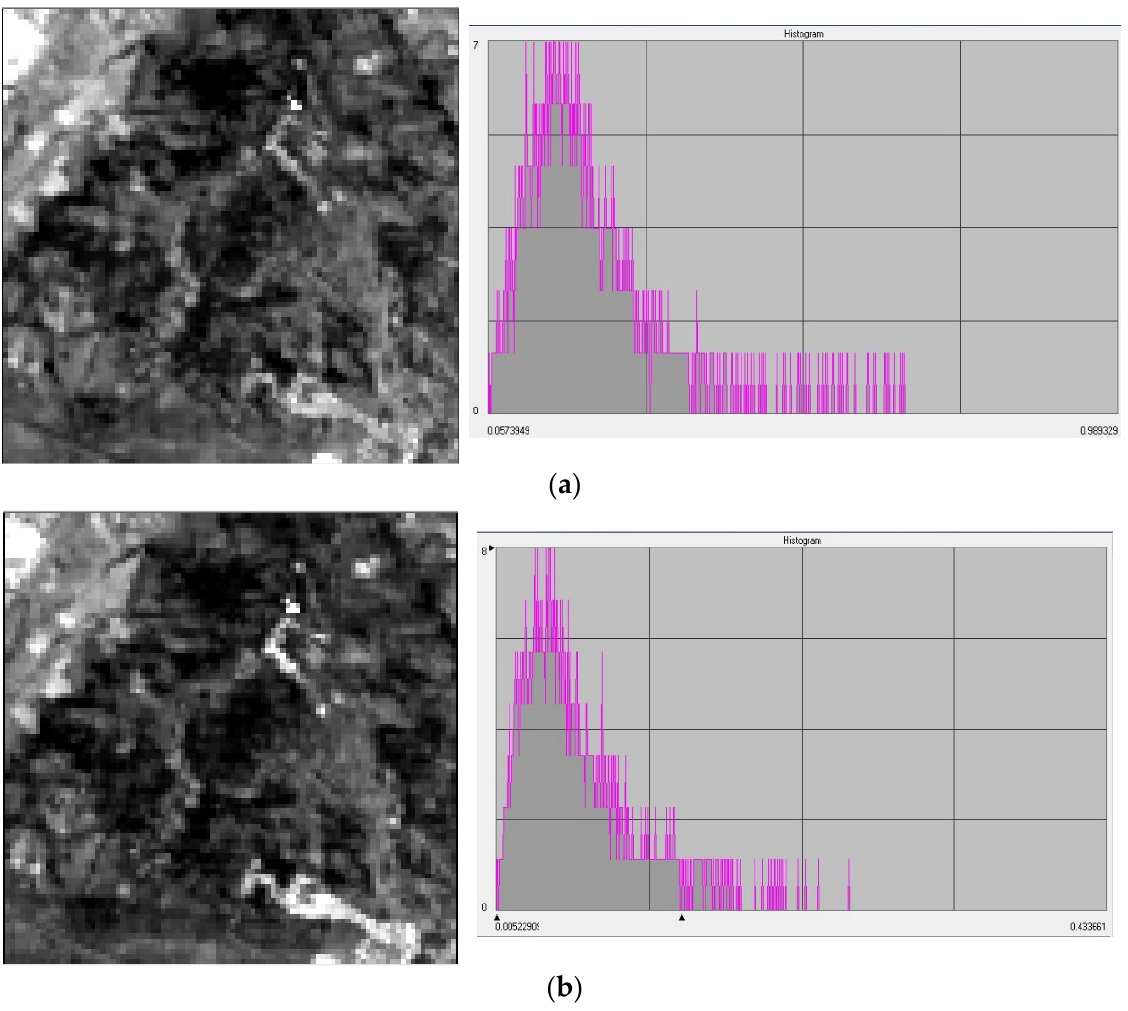
Figure 8. SWIR band ( a ) 57 (1.57 um) ( b ) and 163 (2.43 um) images and histograms after denoising processing.